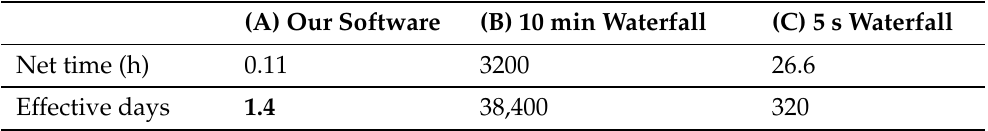
Table 3. Downlink time for the data output of the on-board processing software compared to standard